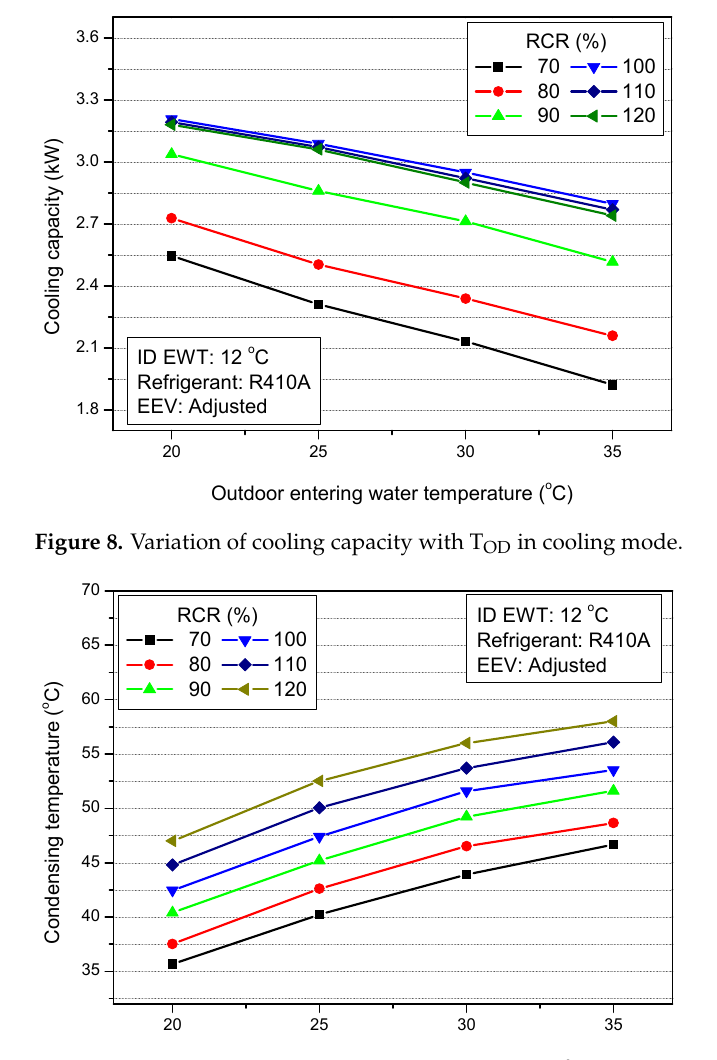
Figure 7. Pressure ratio with variation of refrigerant charge amount and T OD .